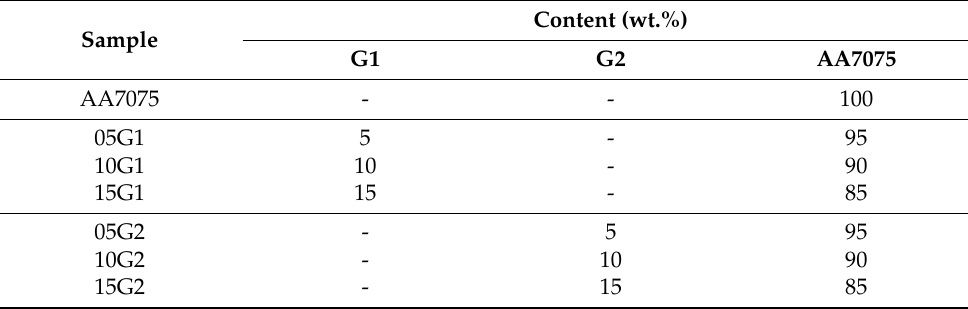
Table 1. Nomenclature of the starting powders according to their